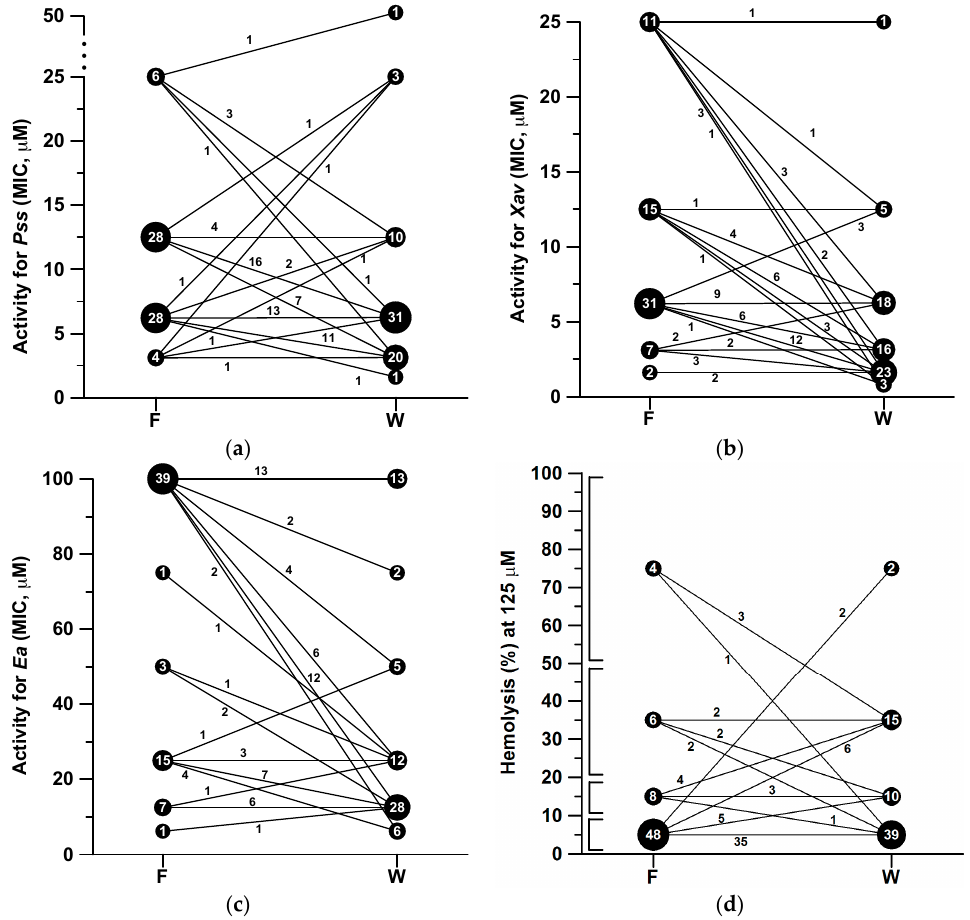
Figure 3. Graphical representation of the antibacterial and hemolytic activity of the cyclic peptides incorporating a Phe or a Trp. Antibacterial activity against ( a ) P. syringae pv. Syringae ; ( b ) X. axonopodis pv. vesicatoria ; ( c ) E. amylovora ; and ( d ) hemolytic activity. The antibacterial activity is given as the minimal concentration that inhibits growth (MIC), and the lowest value of the MIC range is represented. Hemolytic activity was measured at 125 μ M and is expressed as a percentage compared to melittin as a standard. The numbers in the black circles indicate the number of compounds with a given activity, the segment connectors link each Phe-containing peptide with its corresponding Trp-derivative, and the segment labels stand for the number of peptides that follow the same activity trend. The brackets in the y-axis of the hemolytic activity stand for hemolysis percentage ranges.